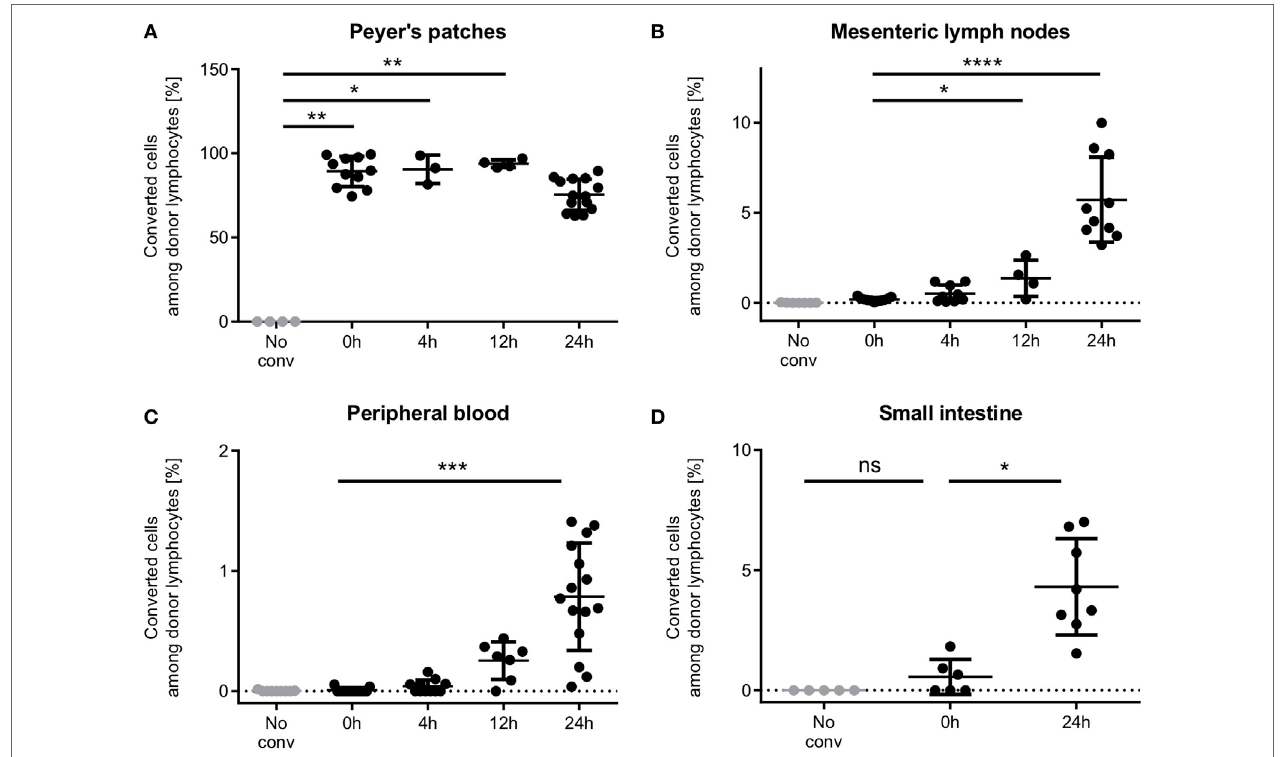
FIGUrE 4 | Time course of T cell homing from Peyer’s patches through the mesenteric lymph nodes and the blood to the small intestine. (A) Peyer’s patches contain high percentages of photoconverted cells within the 24 h period observed. (b) Single cells enter the mesenteric lymph nodes during the photoconversion procedure, and low numbers populate the mesenteric lymph nodes as early as 4 h after photoconversion. 24 h after photoconversion, on average 5.7% of donor cells are from the photoconverted Peyer’s patches. (c) First photoconverted cells appear in the blood after 4 h and increase to an average of 0.78% (range: 0.04–1.41%) 24 h after photoconversion. (D) Cells were readily detected in the intestine 24 h after photoconversion. In some mice, single red cells show up in the intestinal sample, presumably due to contamination. One data point represents one mouse. Statistics are according to an unpaired non-parametric